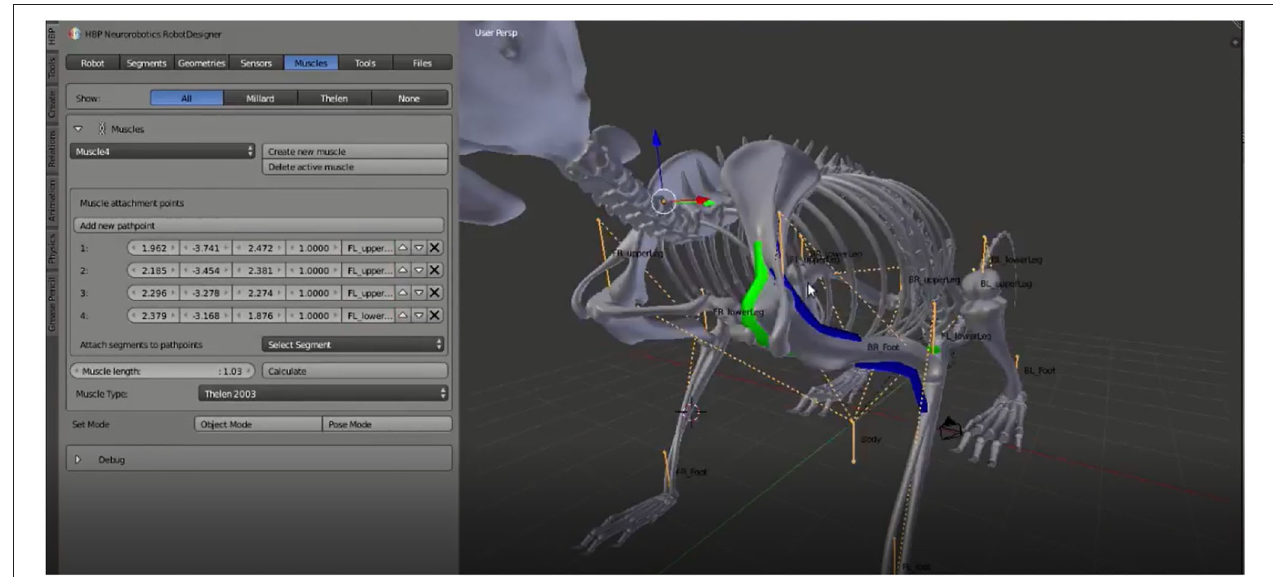
FIGURE 4 | Musculoskeletal Model Design: Muscles are defined for a biological rodent model. Using the GUI and scene interaction, muscles can be specified with an arbitrary number of pathpoints by clicking the desired locations directly on the 3D model. All generated points are listed in the GUI and the exact location can be adjusted. Afterwards, muscle parameters such as muscle type, length and maximal force can be